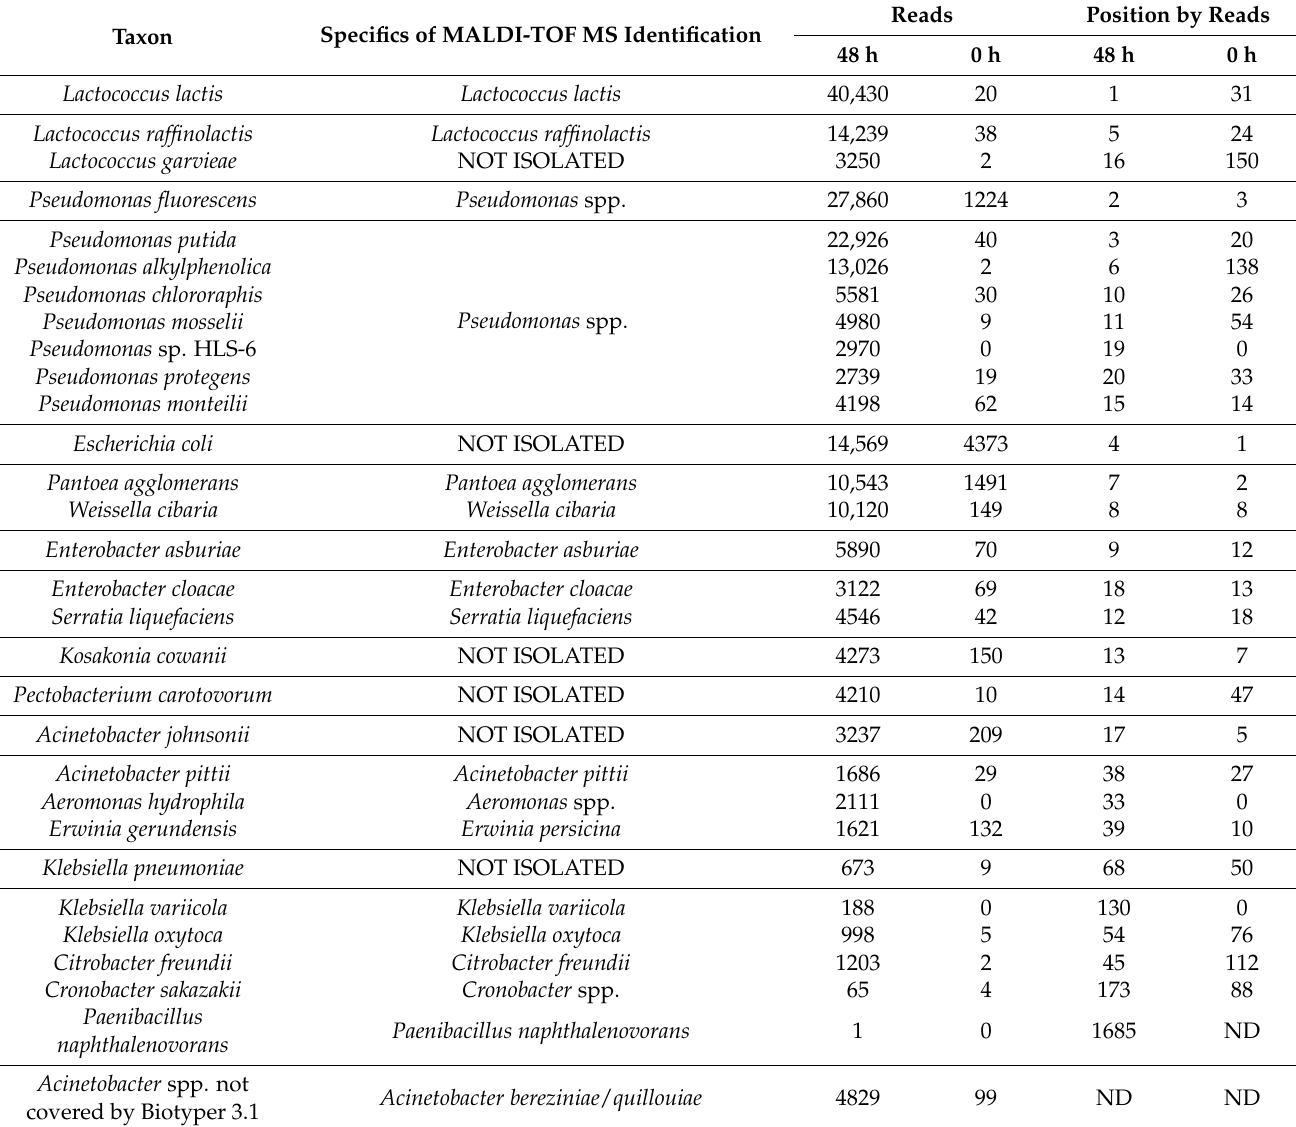
Table 4. Sample B: Comparison of MinION and MALDI-TOF MS identification, ND—not